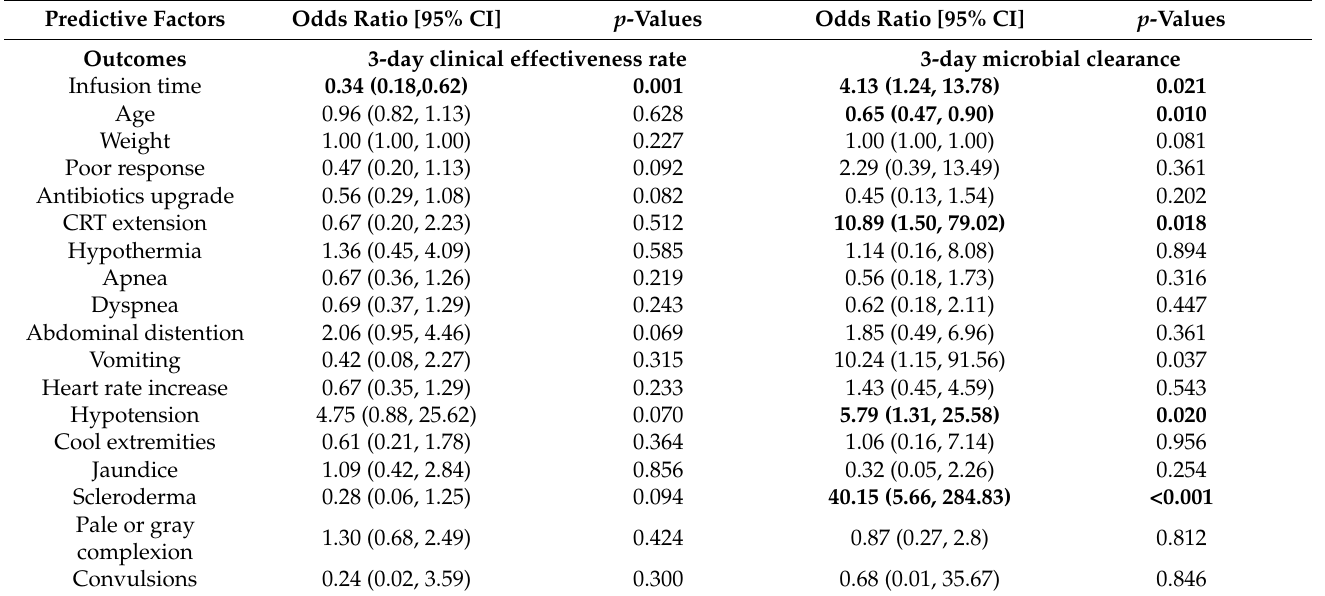
Table 3. Multivariate analysis results of EI of meropenem effectiveness